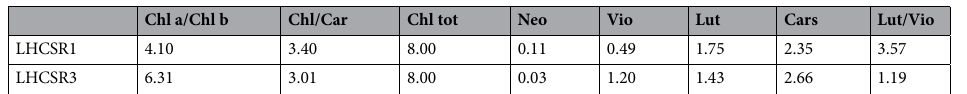
Table 1. Pigment analysis of LHCSR1 and LHCSR3 refolded recombinant proteins. Total amount of carotenoids (Cars) and the level of the different xanthophyll were normalized to 8 chlorophyll (Chl tot) content per aproprotein. Neo neoxanthin, Vio violaxanthin, Lut lutein. Errors are below 15% in each case (n = 2).